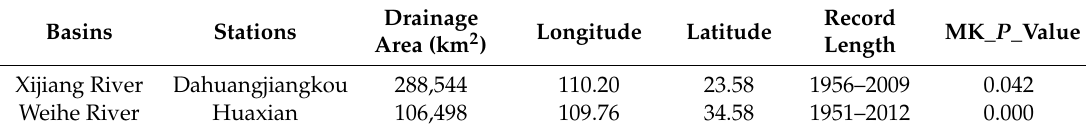
Figure 2. Annual maximum flood series of ( a ) Huaxian and ( b ) Dahuangjiangkou stations with decreasing and increasing trends. Table 1. Data Information of the hydrological stations used in this study.